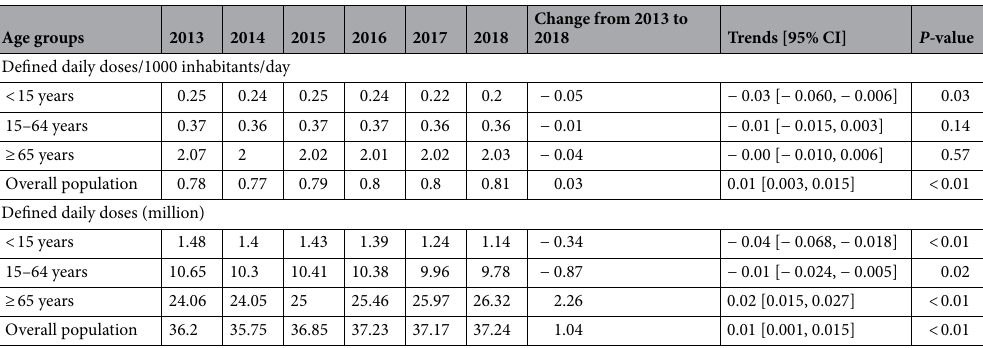
Table 1. Parenteral antimicrobial use from 2013 to 2018 according to age group. Trends are shown as the standardized coefficients from linear regression analysis of each metric from 2013 to 2018. CI, confidence interval.